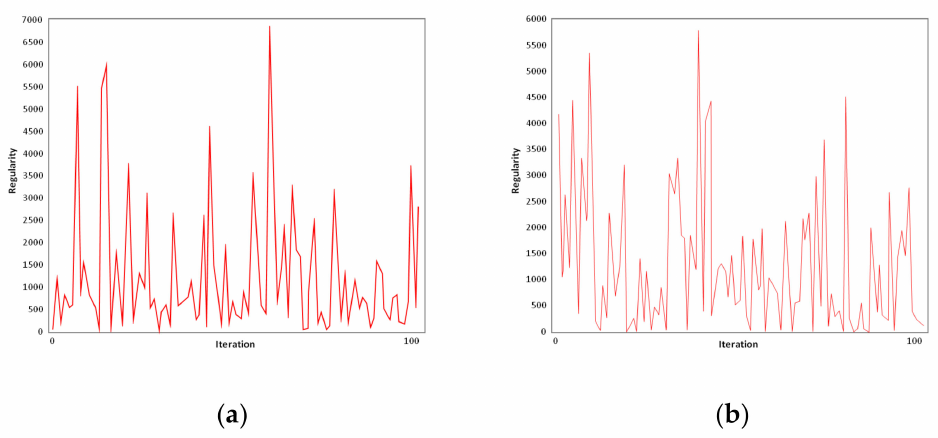
Figure 16. The regularity in case of 2-opt ( a ) and order crossover operator ( b ).